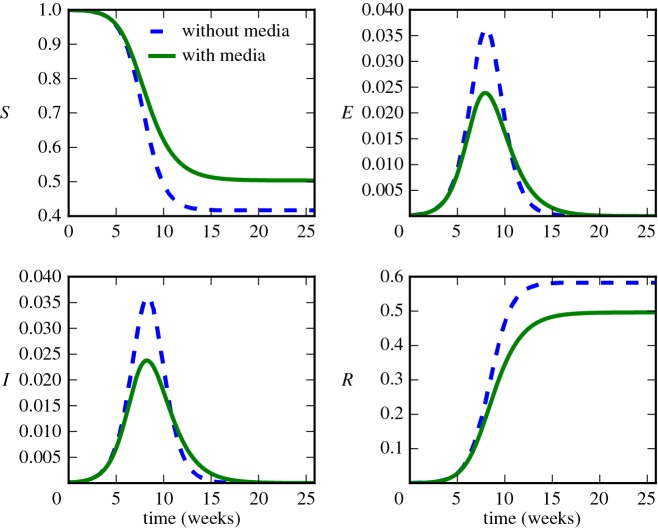
Sample time series showing the effect of the media function fm (I)=1−pmI. The media function reduces the final epidemic size and slows the decay rate of the outbreak.